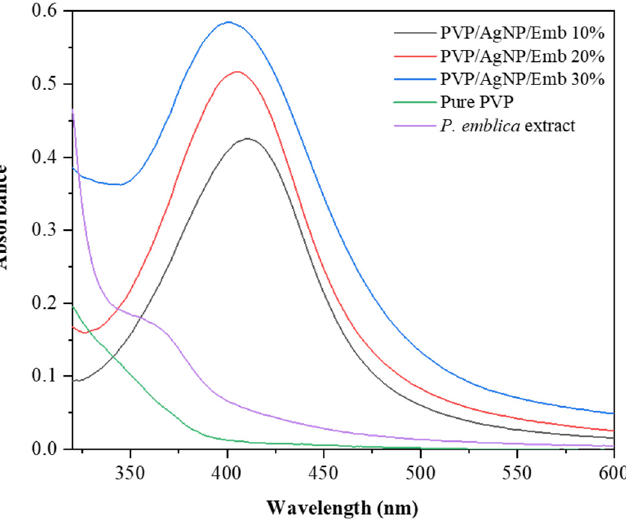
Figure 2. UV/VIS absorption spectra of PVP, Phyllanthus emblica extract, and dressing spray contain- ing different amounts of Phyllanthus emblica extract.